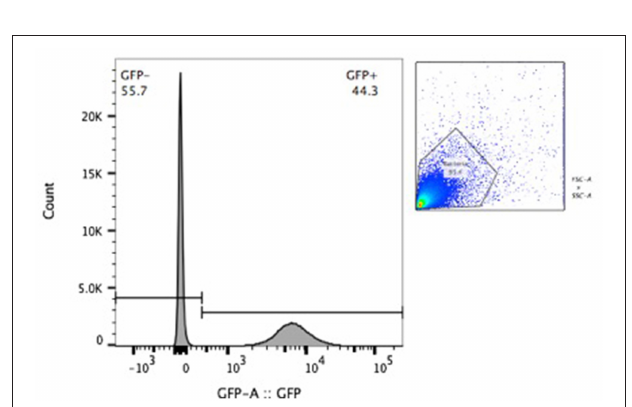
FIGURE 4 | Flow cytometric confirmation of fluorescence of BCG-GFP-LuxFO in a 1:1 mixture of non-fluorescent BCG and BCG-GFP-LuxFO.